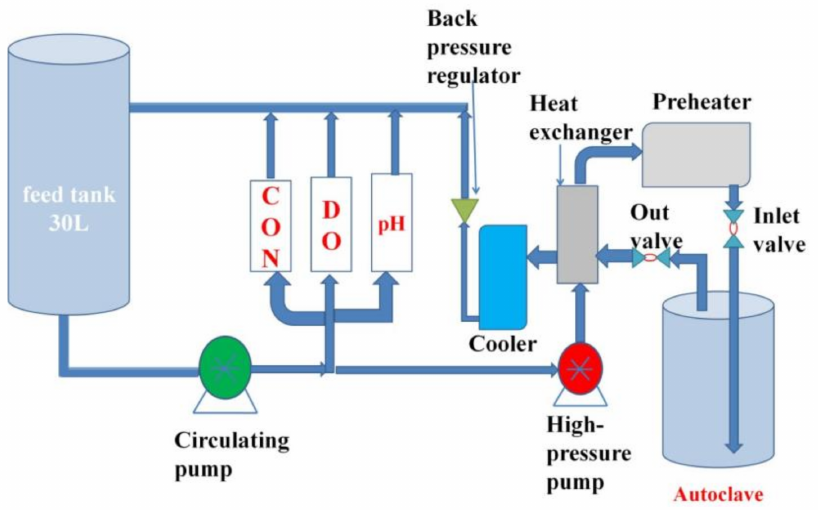
Figure 2. Schematic diagram of the experimental apparatus used in the present